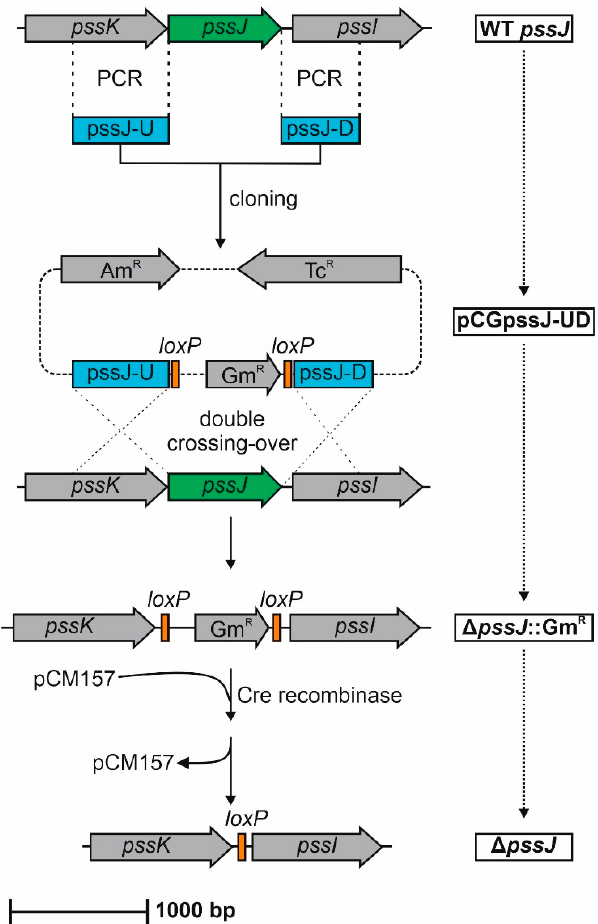
Figure 3. Schematic representation of the steps in the construction of the Δ pssJ mutant of the RtTA1 strain. Details of the construction as well as plasmids used are described in Section 4.